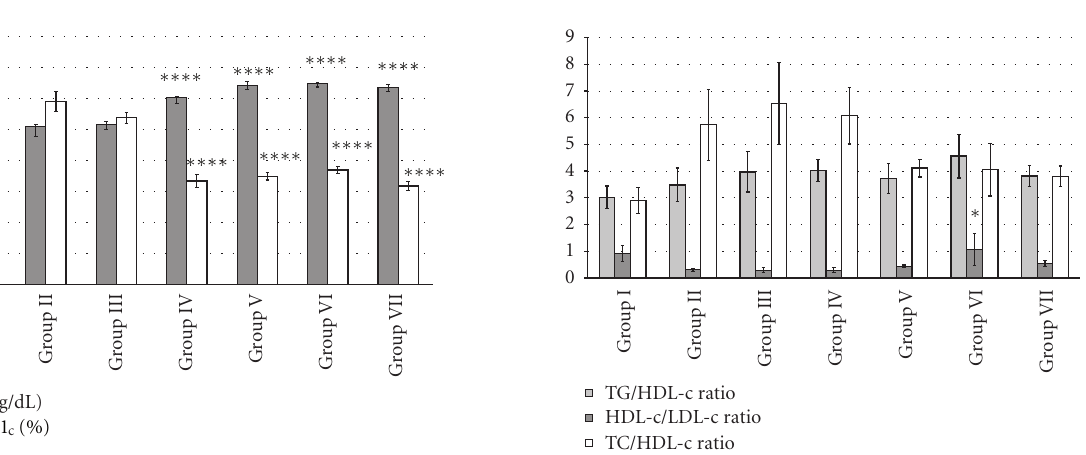
Figure 1: E ff ect of MREt on hemoglobin (g/dL) and glycosylated Figure 2: E ff ect of MREt on cardioprotective indices. Each bar hemoglobin (HbA1 c ) levels. Each bar represents the mean ± SEM represents the mean ± SEM ( n = 6) . ∗ P < 0 . 05, when compared ( n = 6) . ∗∗∗∗ P < 0 . 0001, when compared with group II and III. with group II and Table 1: Phytochemical analysis of MREt of R. serpentina . Quantitative analysis Phytoconstituent Qualitative analysis (mg/gm)